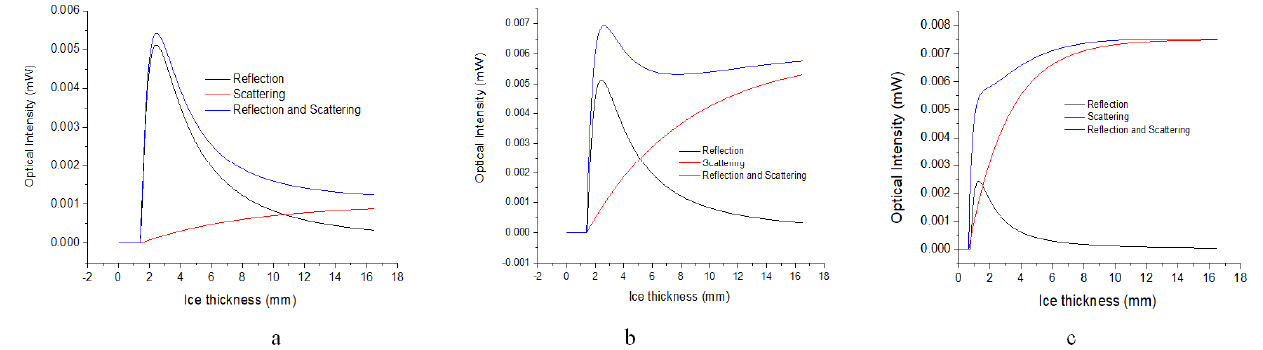
Figure 5. Modeling of the reflections (black), scattering (red), and combined reflection and scattering (blue) contributions to the optical signal detected by the fiber 4 (next to the source fiber) for ( a ) glazed ice, ( b ) mixed phase ice, ( c ) and rime ice.